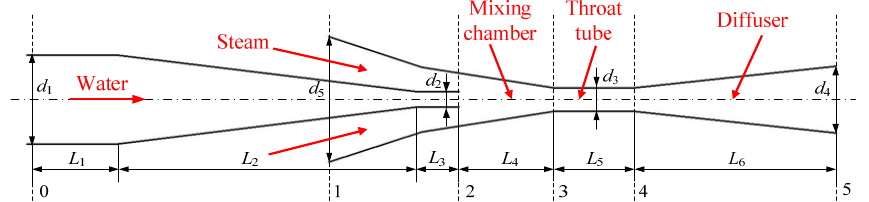
Figure 1. Schematic of the centered water nozzle steam–water injector.